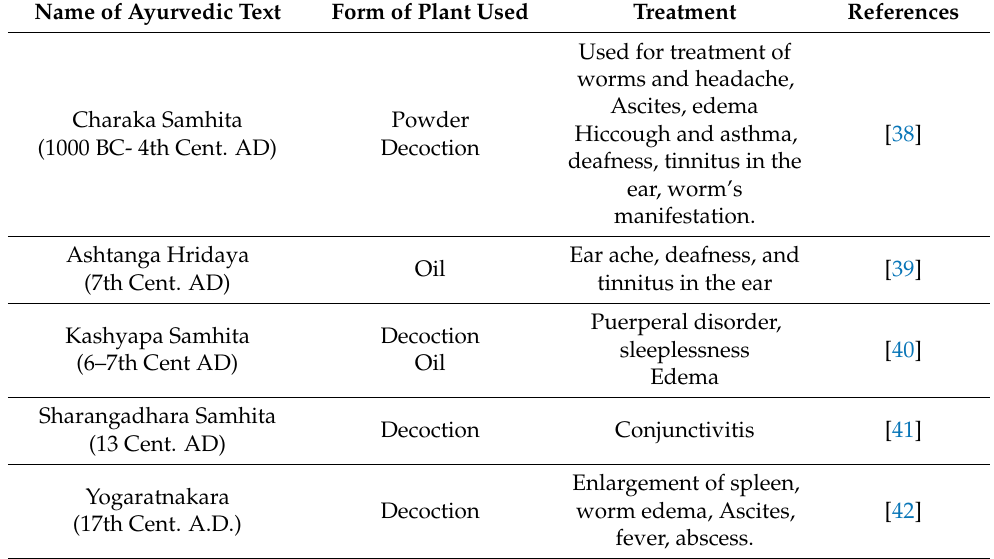
Table 1. Uses of Moringa oleifera listed in Ayurvedic medicinal textbook. Name of Ayurvedic Text Form of Plant